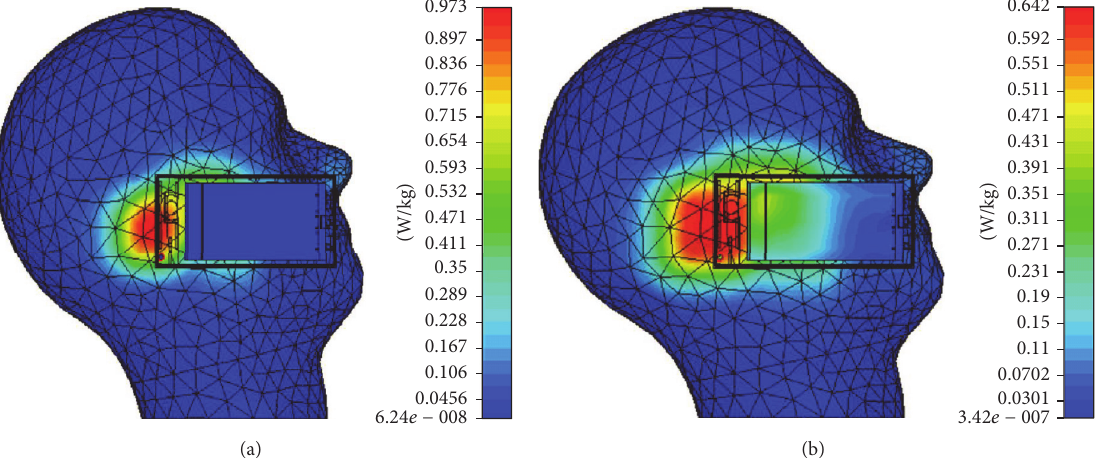
Figure 15: SAR distribution at 2550 MHz: (a) average 1-g and (b) average